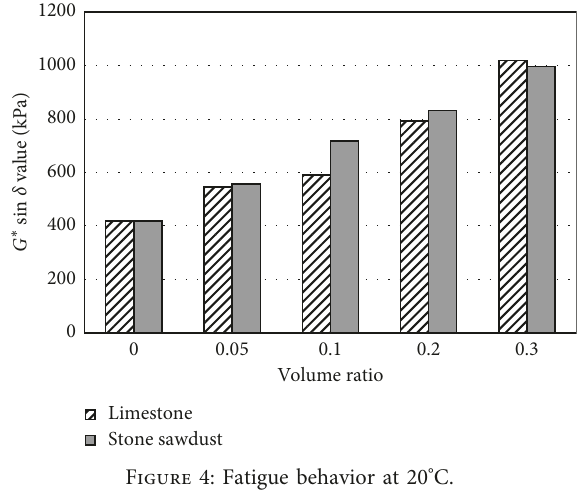
Figure 4: Fatigue behavior at 20 ° C.